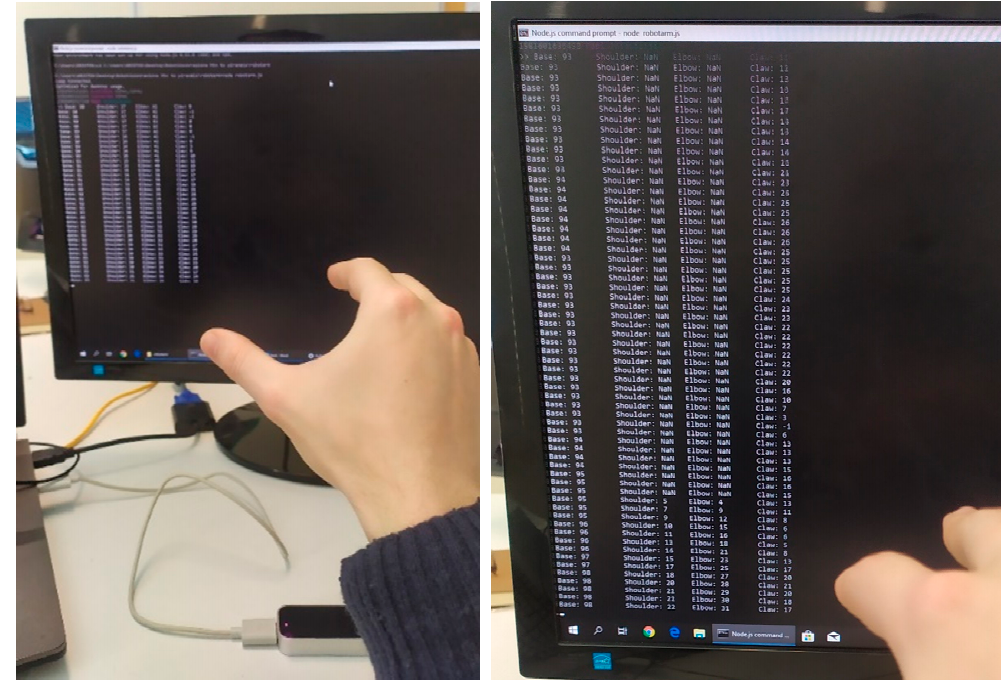
Figure 11. Leap software’s distance of shoulder, elbow, claw points from sensor.